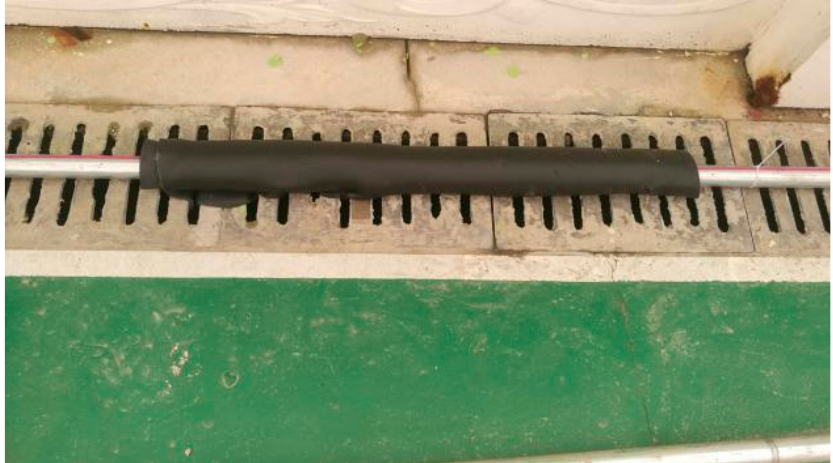
Figure 7. Steel pipe is covered with thermal insulation cotton.